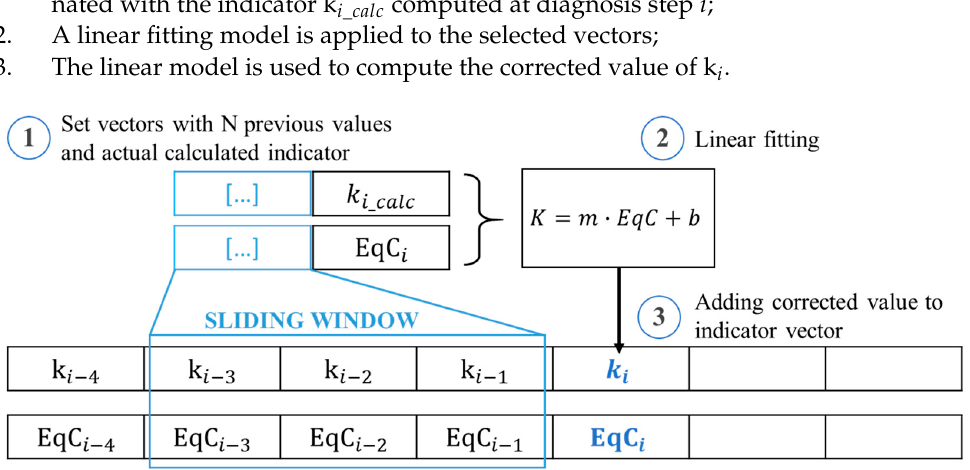
Figure 4. Three-step procedure to correct the degradation indicators applying a linear fitting model. The sliding window is applied to smooth the indicator small fluctuations and to high-